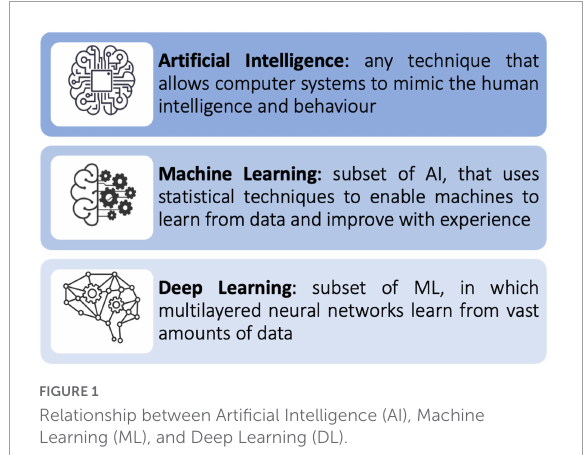
FIGURE1 Relationship between Artificial Intelligence (AI), Machine Learning (ML), and Deep Learning